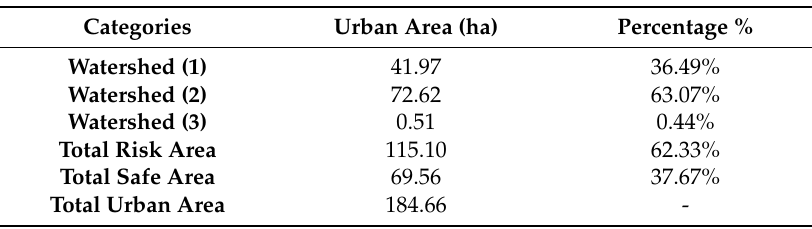
Table 3. The watershed at risk area statistics.